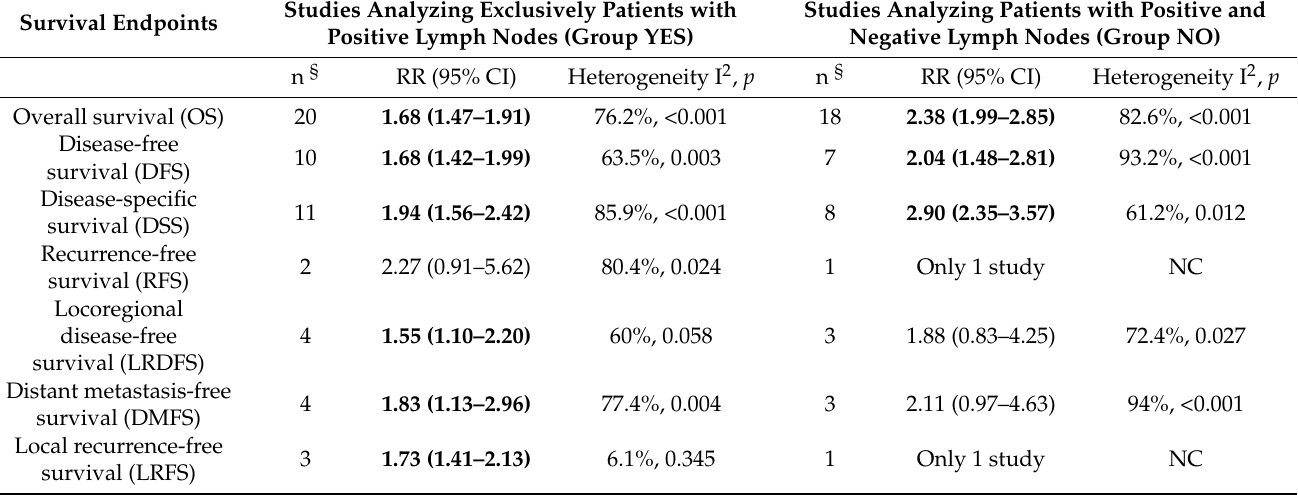
Table 2. Correlations between lymph node ratio (LNR) and survival outcomes; subgroup analyses by LNR cut-off values are presented. Significant associations are noted in